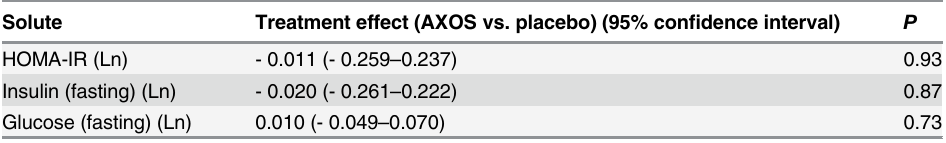
Table 4. Influence of arabinoxylan oligosaccharides (AXOS) on insulin